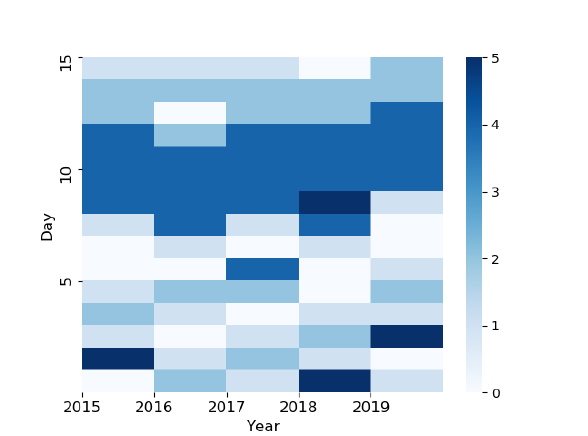
Figure 20: Clustering output for O 3 for first 15 days in Q 4 over 2015 to 2019.